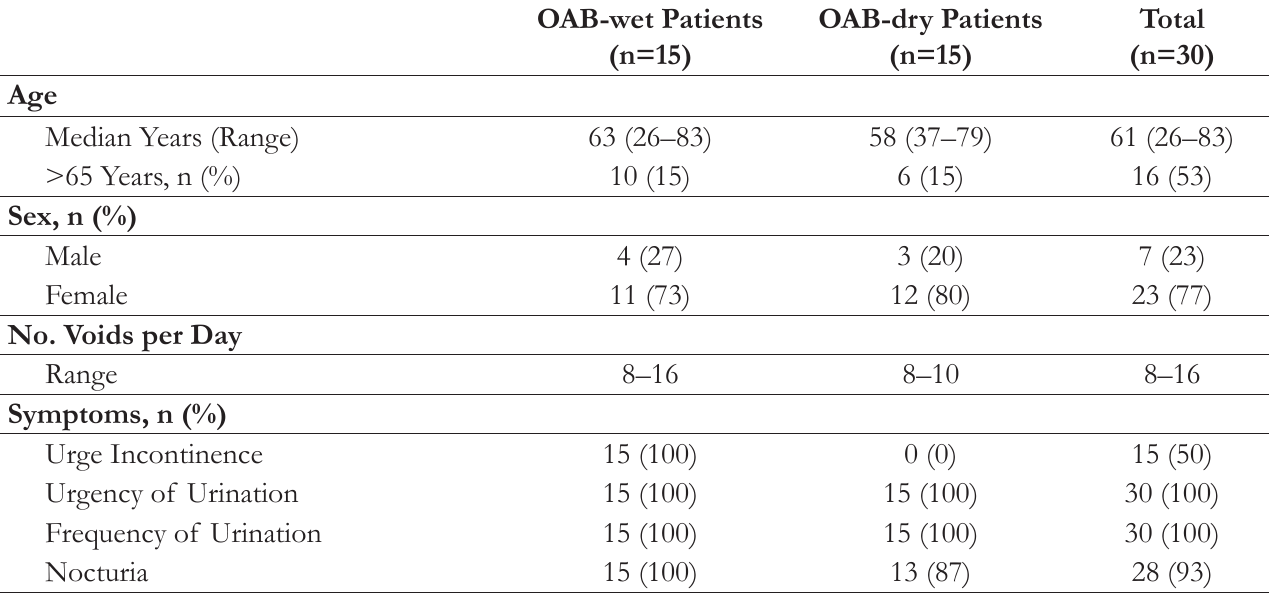
Table 1. Patient Demographics and Symptoms